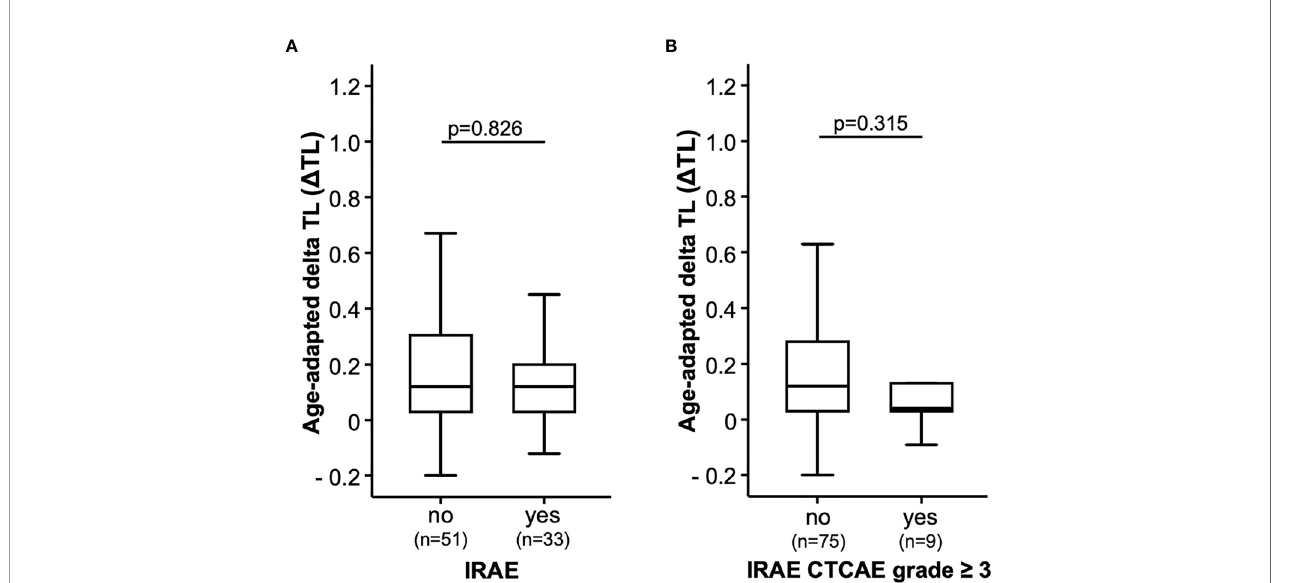
FIGURE 4 | Immune-related adverse events during immune checkpoint inhibitor therapy. The age-adapted delta telomere length ( D TL) is shown (A) in a group of patients without (no) or with (yes) immune-related adverse events (IRAEs). (B) In addition, D TL is shown in patients with severe IRAEs > grade III (yes) and in those patients who do not